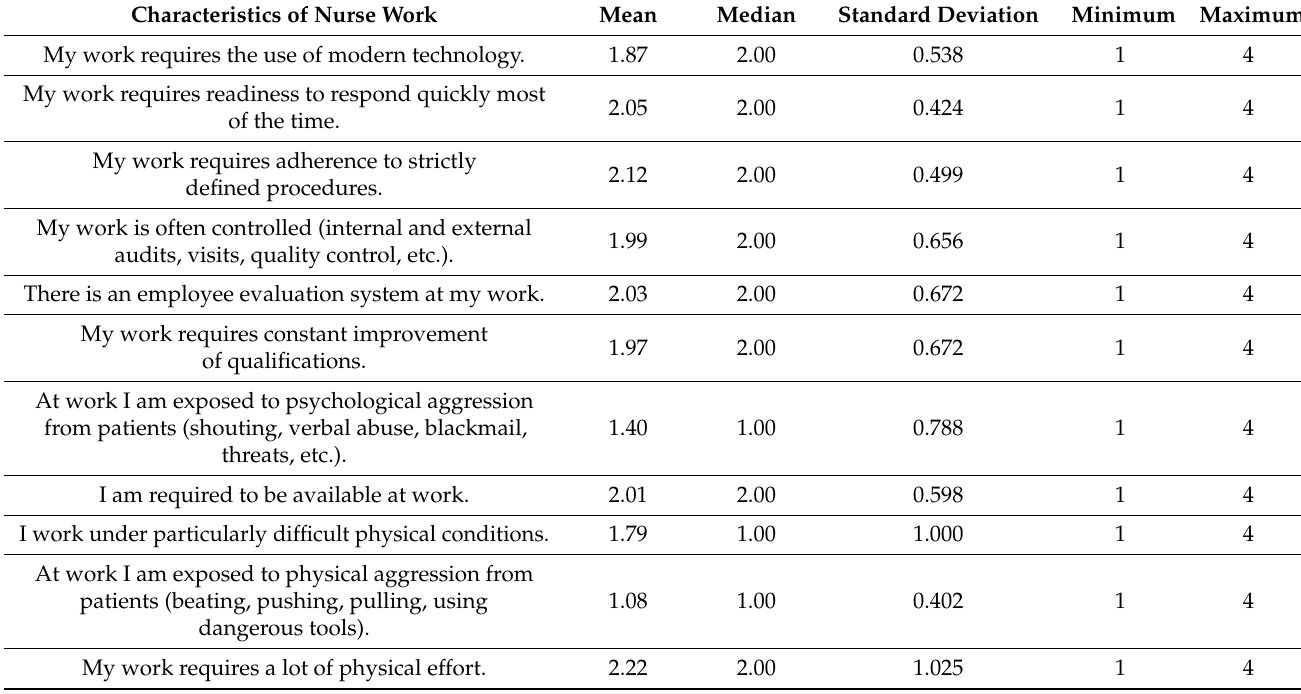
Table 3. The most common characteristics of nurse work in health care ( N = 138). Characteristics of Nurse